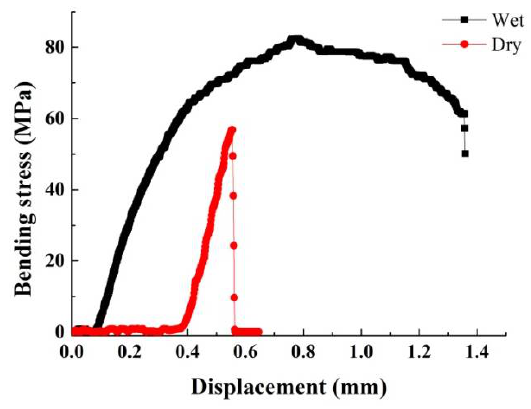
Figure 13. Curves of bending stress–displacement.